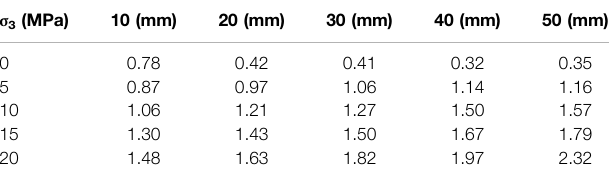
TABLE 5 | Peak Strain (10 – 2 ) of the RCR composites at different inclined coal seam thicknesses and different con fi ning pressures.